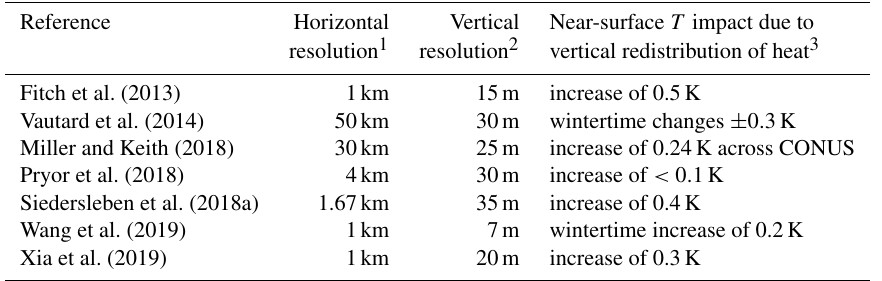
Table 1. Overview of previous WRF WFP wake impact studies Reference Horizontal Vertical Near-surface T impact due to resolution 1 resolution